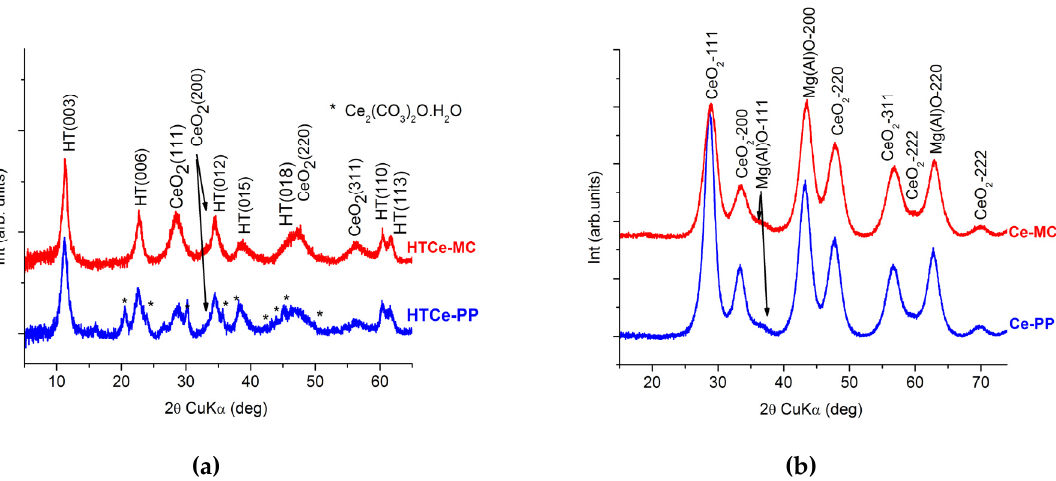
Figure 1. Diffraction patterns of the layered double hydroxides modified with cerium prepared by co-precipitation and mechanochemically under ( a ) dried form (HTCe-PP and HTCe-MC) and ( b ) calcined form (Ce-PP and Ce-MC).